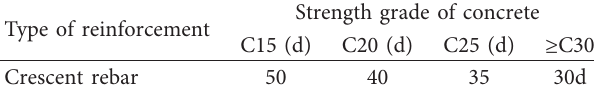
Table 2: The formula for calculating anchorage